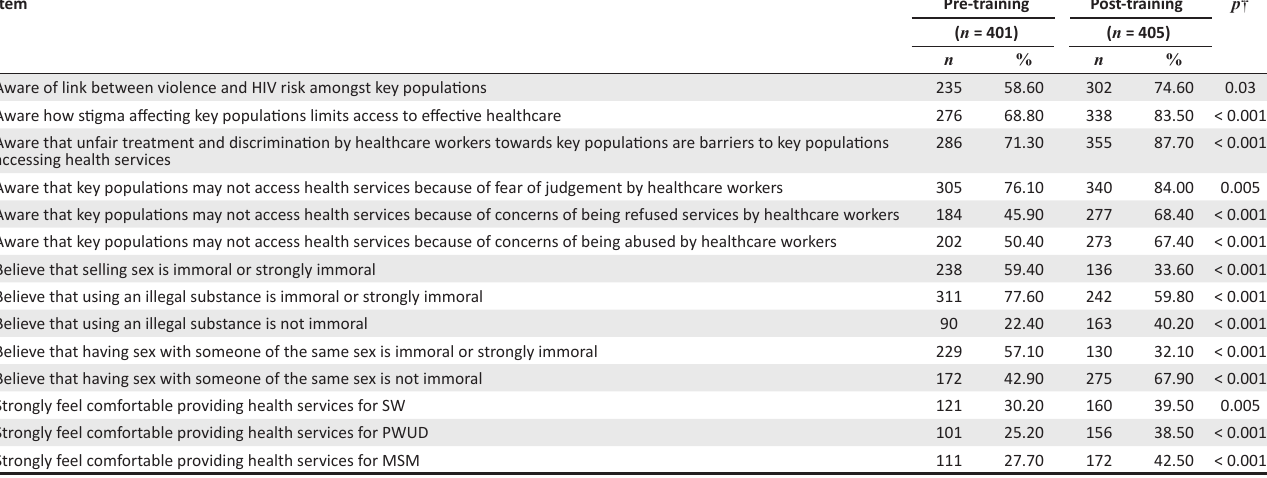
TABLE 1: Changes in pre- and post-training assessment items. Item Pre-training